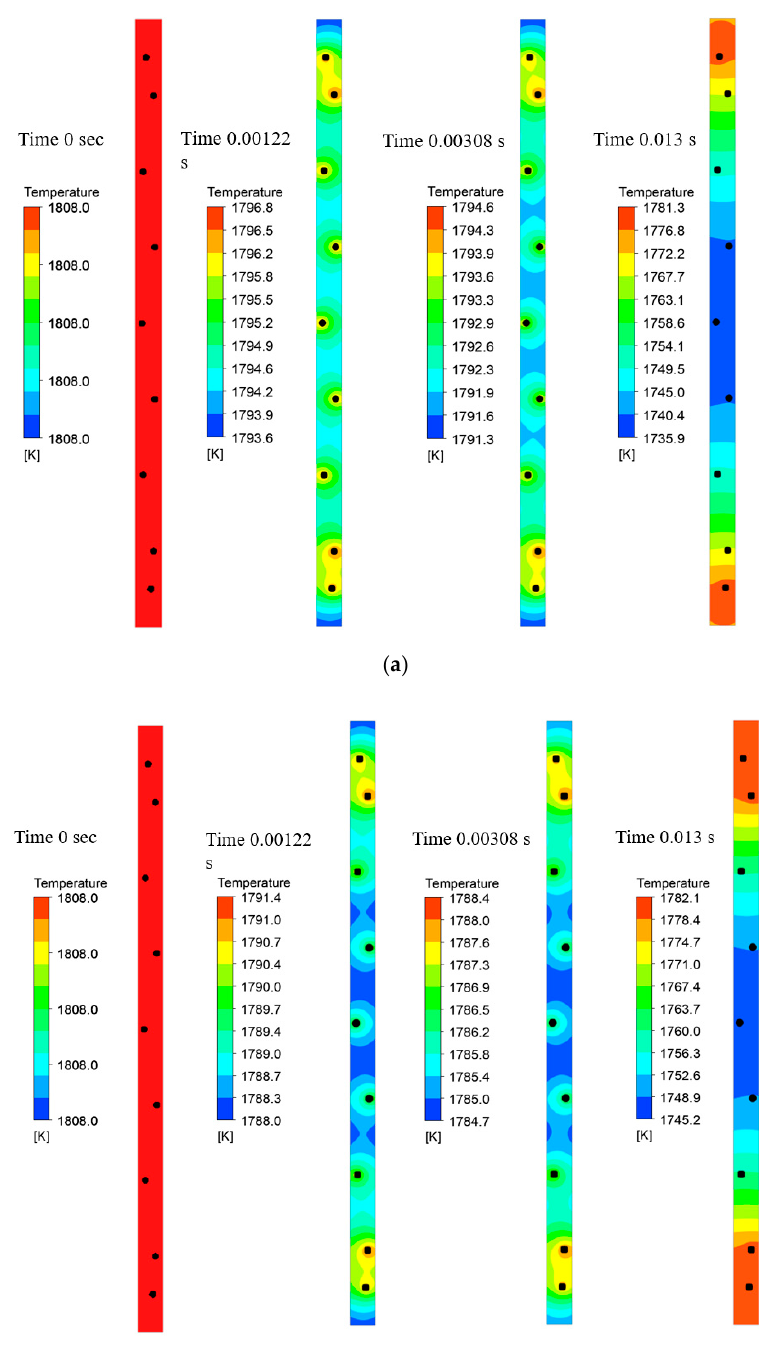
Figure 10. ( a ) Temperature profile and inclusion motion at 10 ppm sulfur concentration, ( b ) temperature profile and inclusion motion at 64 ppm sulfur concentration.